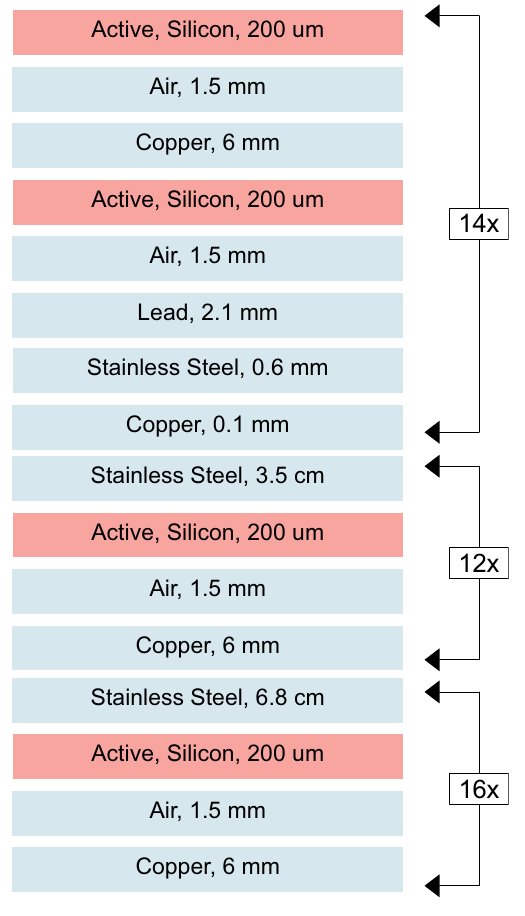
Fig. 3 Layers of the detector. Top 8 blocks in the diagram represent the electromagneticsectionof the calorimeter, andthe rest, the hadronic section